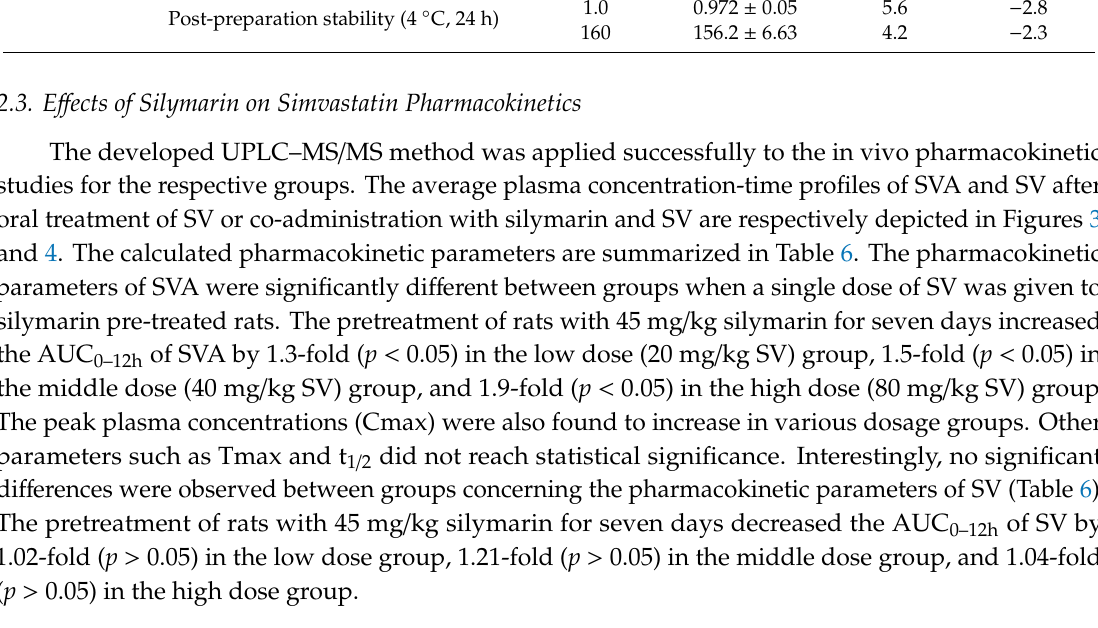
Table 5. Stability of SVA and SV in rat plasma under various storage conditions (mean ± SD, n = 5). Analytes Storage Conditions Short-term stability SVA